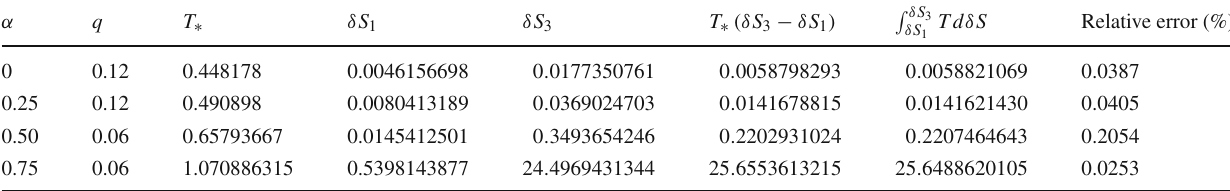
Table 8 Numerical check of equal area law in T – δ S graph for n = 4 ,θ 0 = 0 . 3 , l = 1 , b = 1 , k =